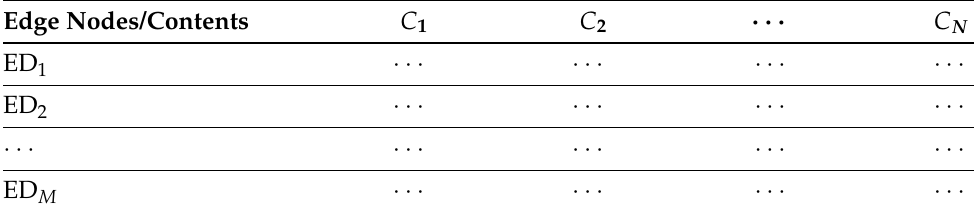
Table 4. REQ: History of